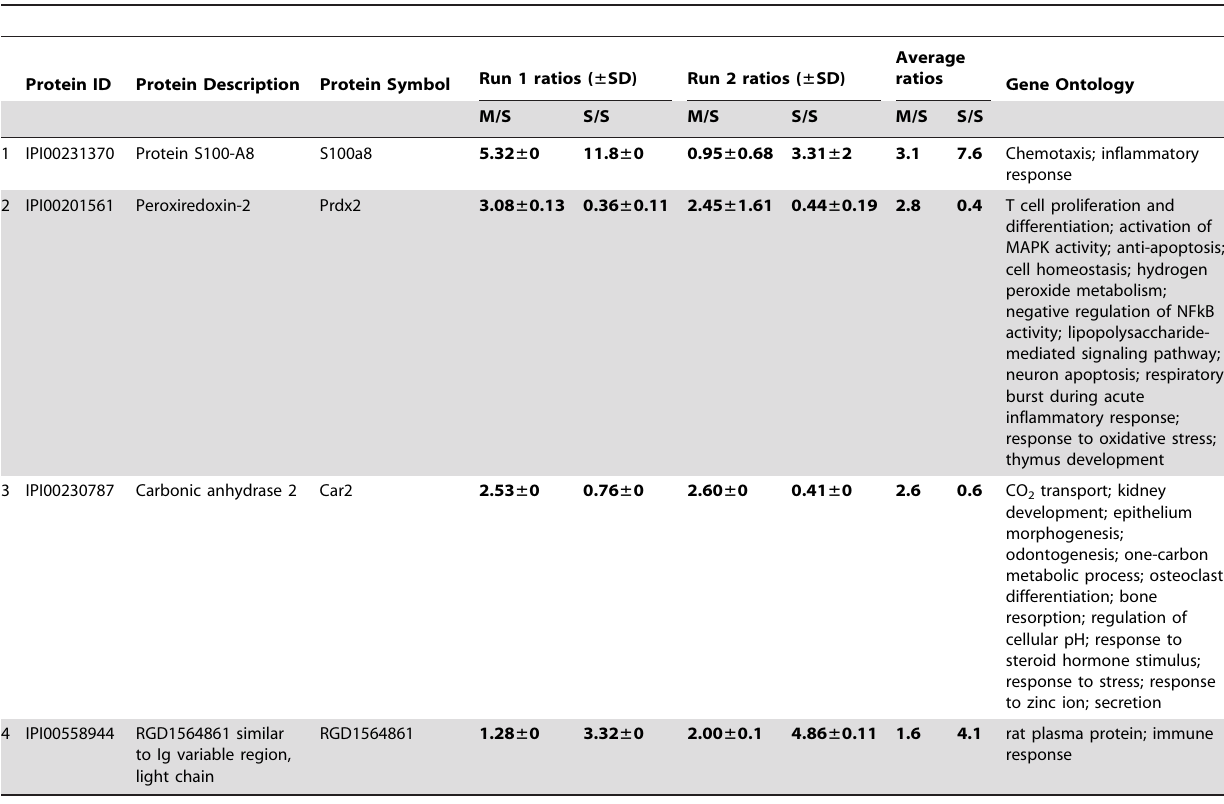
Table 4. Potential biomarkers of SCI severity identified by quantitative LC-MS/MS analysis of CSF from rats following experimental SCI.